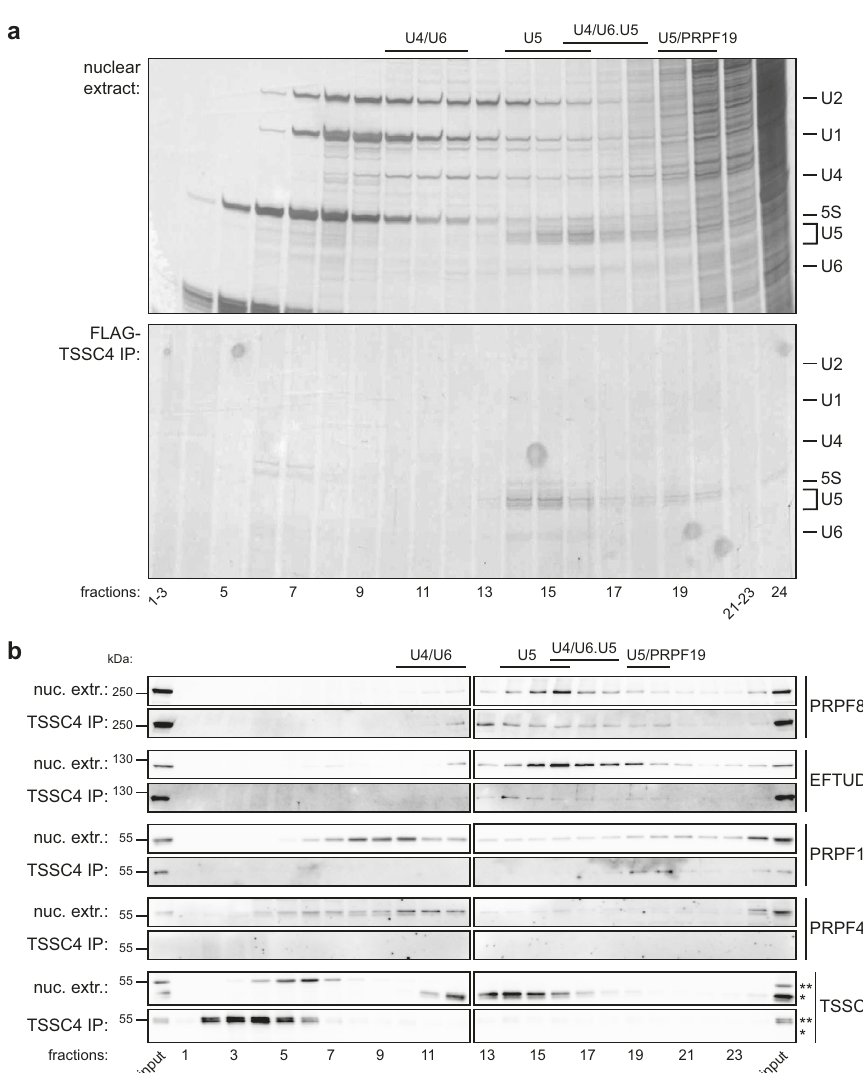
Fig. 2 TSSC4 interacts with two U5 snRNA-containing complexes. a Complexes co-precipitating with TSSC4-FLAG were eluted by a FLAG peptide and resolved by ultracentrifugation on 10 – 30% glycerol gradient. RNA was isolated from each fraction, resolved on UREA-PAGE gels, and silver-stained (bottom). A whole-nuclear extract was run in parallel to identify fractions where individual snRNPs sediment (top). b After RNA preparation ( a ), proteins were isolated from the organic phase and detected by western blotting. Lighter complex sedimenting in fractions 14 – 16 contains primarily U5 snRNA and U5-speci fi c proteins (PRPF8 and EFTUD2) and heavier complex migrating in fractions 19 – 20 contains U5 snRNA, U5-speci fi c proteins, and the PRPF19 protein. Endogenous TSSC4 marked by an asterisk (*), TSSC4-FLAG marked by double asterisks (**). The positions of molecular weight markers are shown. a , b The experiment was performed two times with a similar result. Uncropped and unprocessed scans are provided in the Source Data fi